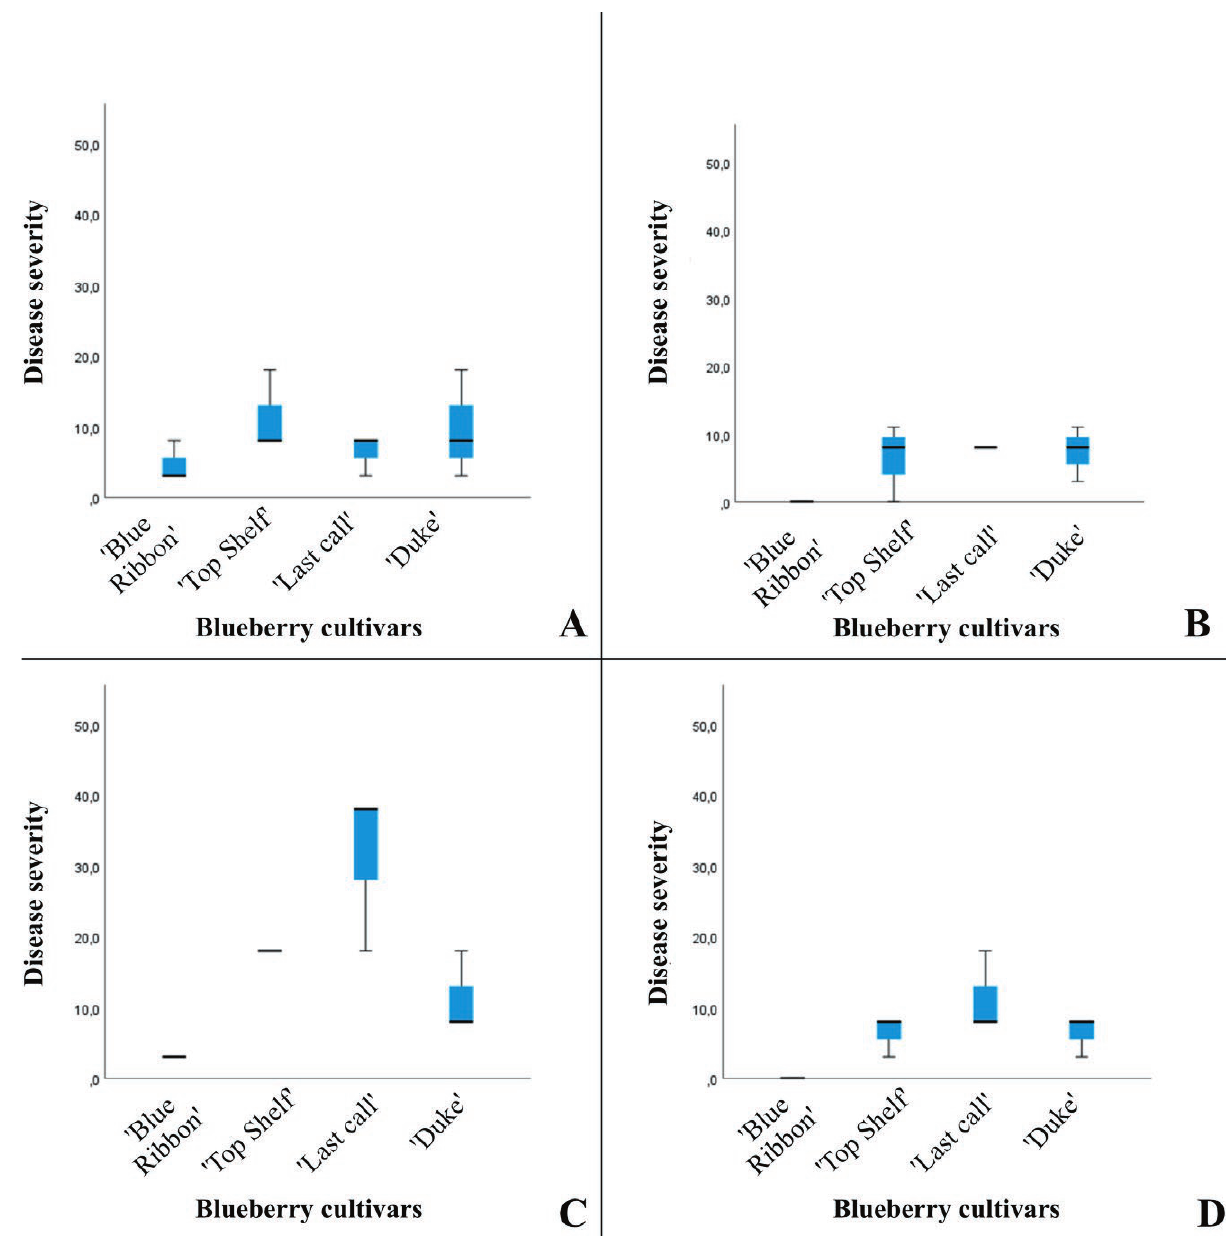
Figure 5. Box plots showing the results of the pathogenicity tests on wounded attached blueberry leaves (A with strain CVG628 and C with CVG629), and on unwounded attached leaves (B with strain CVG628 and D with CVG629). Boxes represent the interquartile range, and the horizontal line within each box indicates the average value. The Kruskal-Wallis test was carried used to compare the mean leaf areas infected after inoculations on four cultivars, and significant differences were accepted at P <